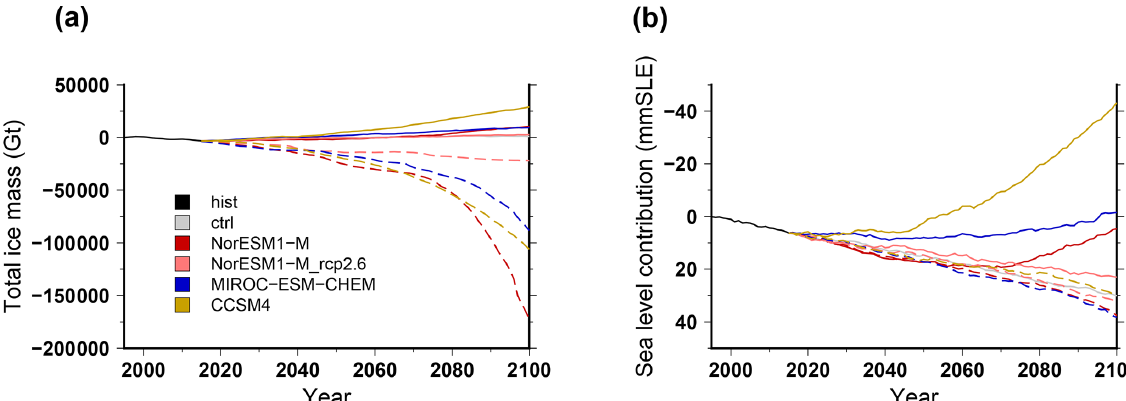
Figure 12. Simulated total ice mass change (a) and ice volume contributing to sea level rise (b) for projections under the different CMIP5 forcings using the RCP8.5 scenario and the medium oceanic sensitivity. For the projections, the solid lines stand for experiments under atmospheric-forcing change only (no change in sub-shelf melting rates), while the dashed lines stand for experiments under oceanic-forcing change only (no change in surface mass balance or surface temperature). The evolutions begin with the historical simulation hist (1995–2015), and the control experiments ctrl and ctrl_proj are depicted in grey (solid and dashed, respectively).